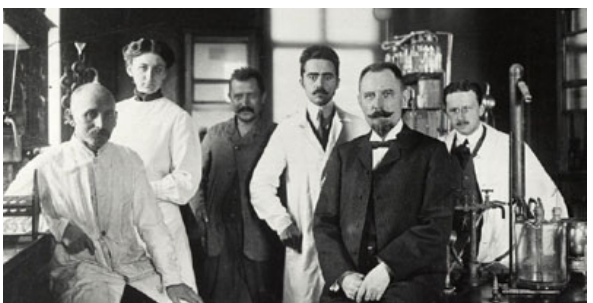
Figure 1. The founder of the pH scale: Soren Peter Lauritz Sørensen (center right) in the Carlsberg Copenhagen laboratory. The author recalls with pleasure the abundant supply of Carlsberg beer on The RRS Discovery on the International Indian Ocean Expedition of the early 1960s, facilitated no doubt by Sørensen’s early work.